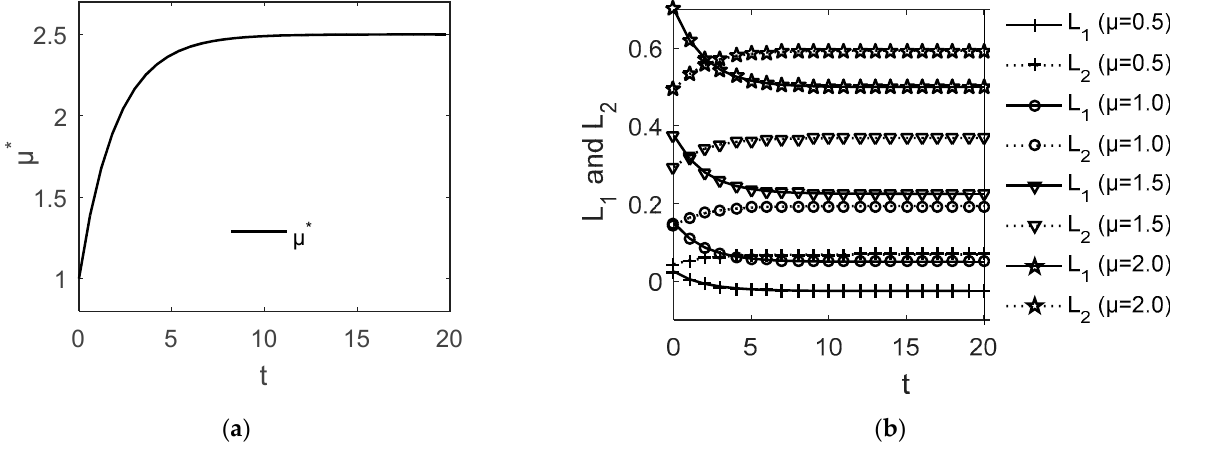
Figure 1. The boundary of reward and punishment coefficient that can increase the total income and the boundary of the maximum penalty that can improve the income of the construction enterprise and the income of construction workers at the same time. ( a ) The boundary of reward and punishment coefficient, where 𝜇 ∗ is the upper boundary. ( b ) The boundary of the maximum penalty, where 𝐿 (cid:2869) is the lower boundary and 𝐿 (cid:2870) is the upper boundary.